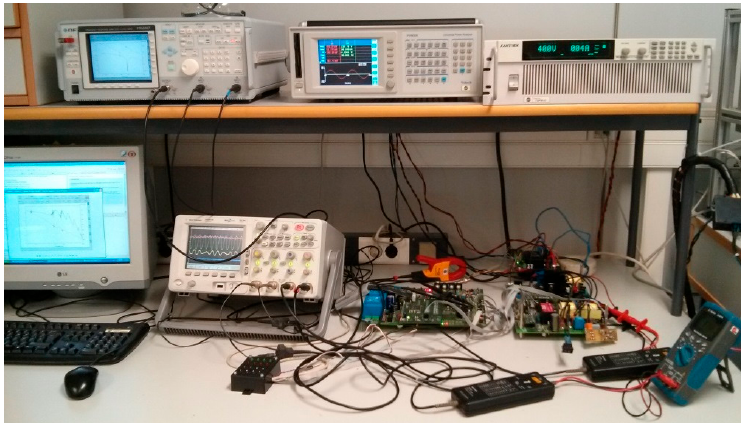
Figure 11. Experimental setup.